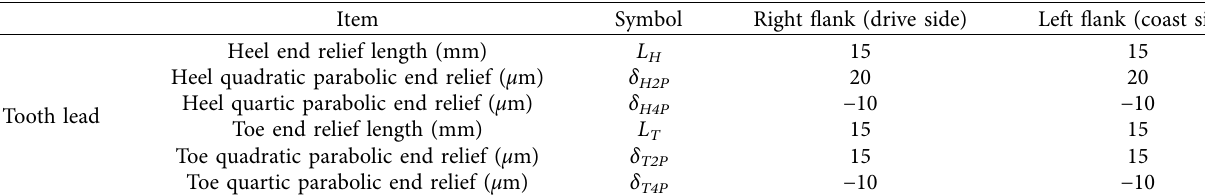
Table 3: Micromodification parameters of beveloid gear.